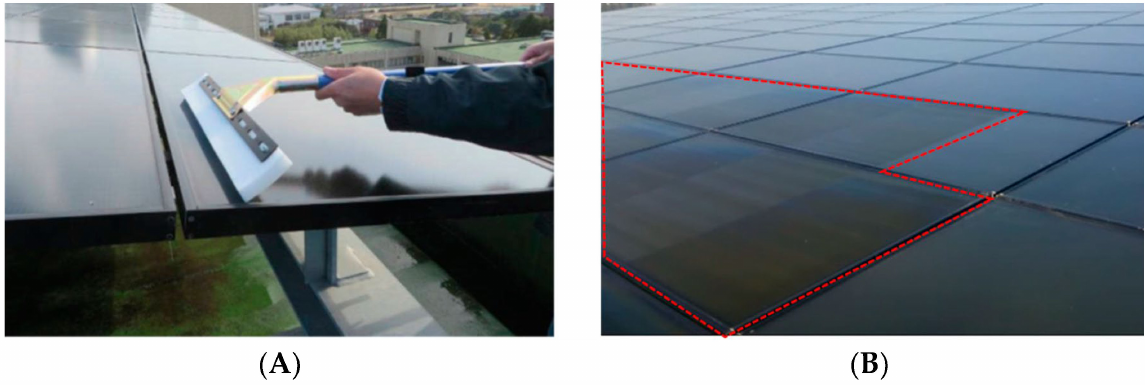
Figure 8. ( A ) Coating method using sponge phase resin; ( B ) surface of the PV modules